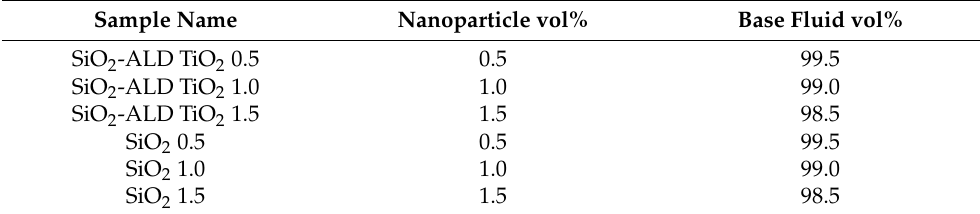
Table 4. Composition of the SiO 2 and the composite